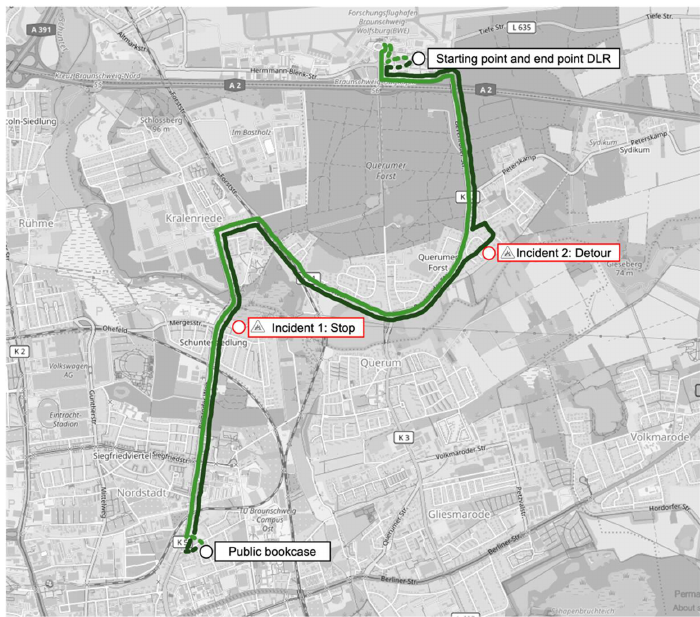
Figure 3. Map of the route. Total route of the study. The first ride to the public bookcase is marked in light green, the second ride in dark green. The dashed lines represent distances walked and the solid lines represent distances traveled in the shuttle. The starting and end point, the public bookcase, and the incidents which occurred on the second ride are marked. © OpenStreetMap contributors [30].